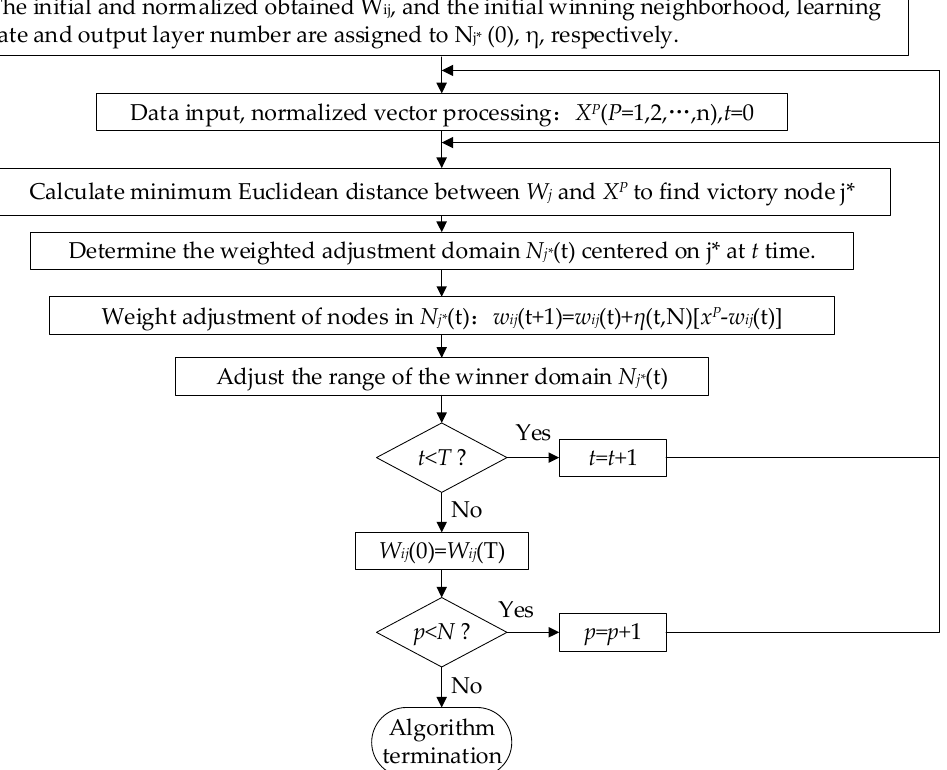
Figure 5. Flow chart for the self-organizing feature mapping (SOFM) algorithm.